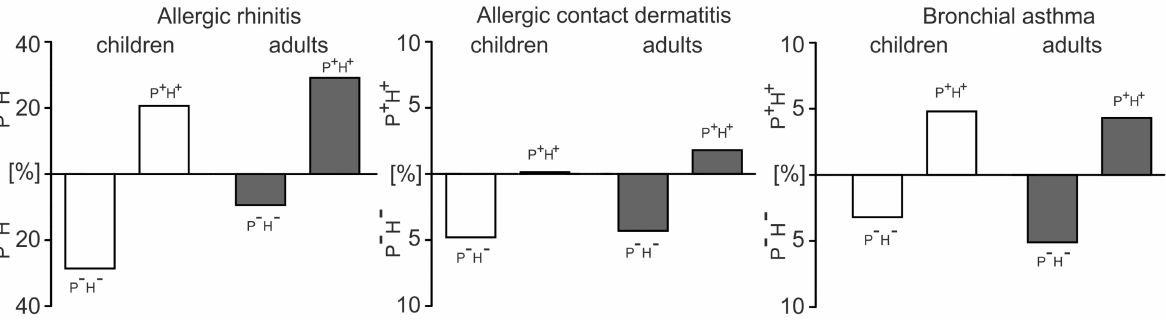
Figure 4. The incidence of concomitant sensitization to pollens and herbs (P + H + ) or lack of such association (P − H − ) in adults ( n = 117) and children ( n = 63) suffering allergic rhinitis, allergic contact dermatitis or bronchial